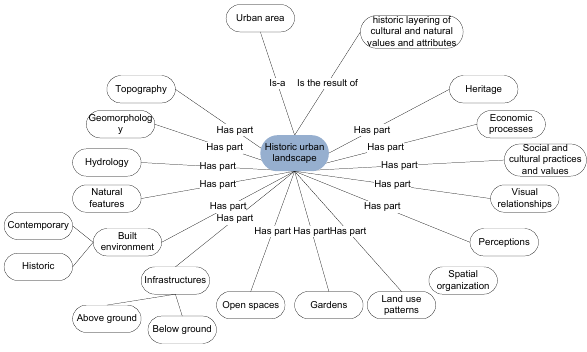
Figure 3. Conceptual representation of the location information according to the CIDOC-CRM (image from http://www.cidoc- crm.org/FunctionalUnits/location-information).